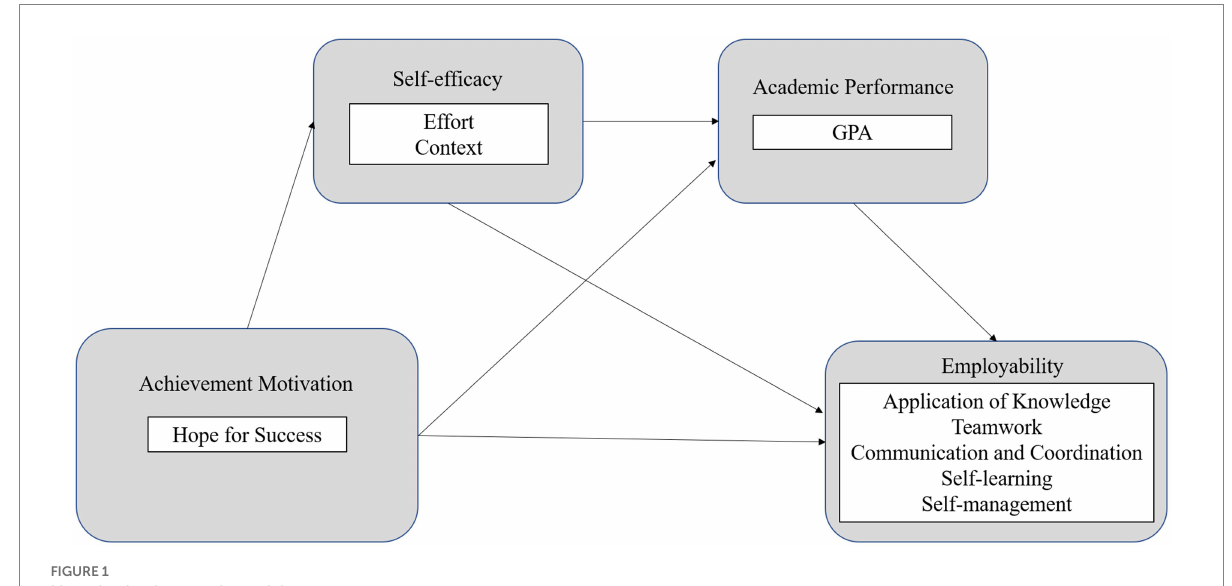
FIGURE 1 Hypothesized research model.